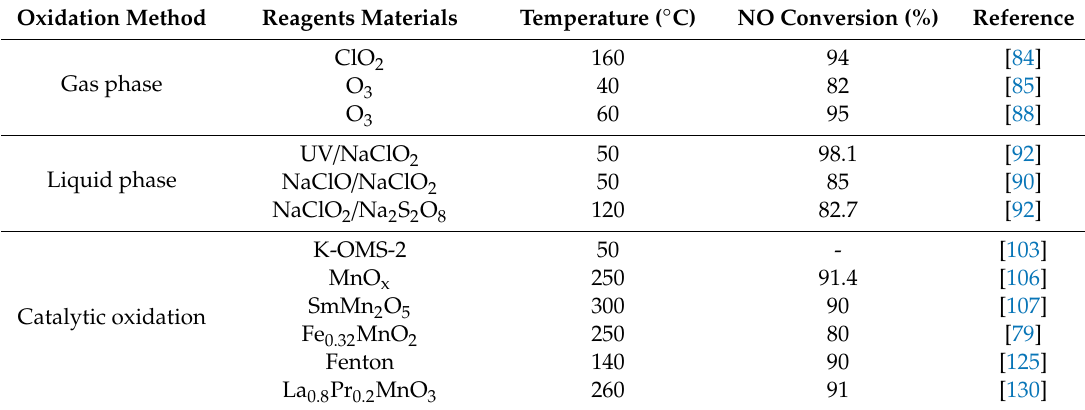
Table 3. Removal of NO x by